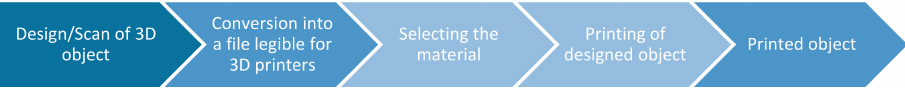
Figure 1. Working stages in 3D